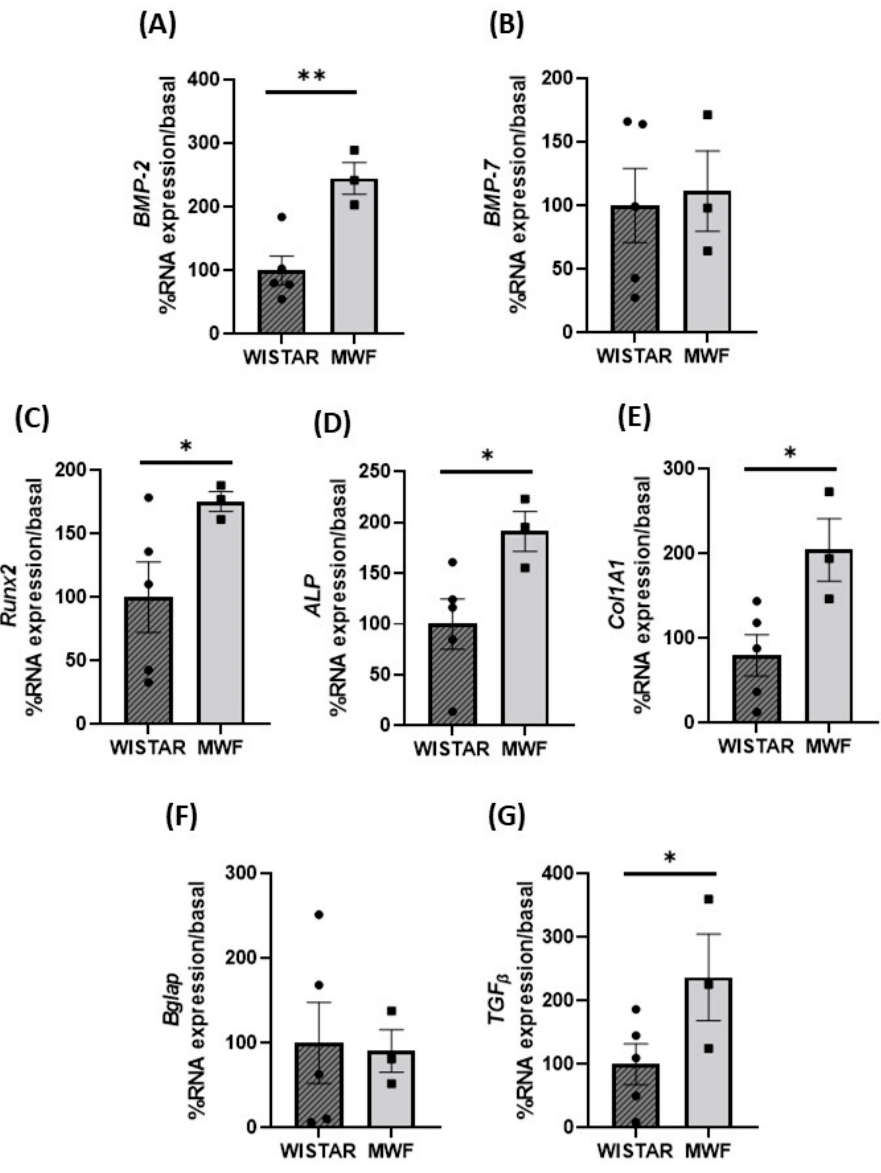
Figure 5. Expression of profibrotic and calcification makers in mesenteric perivascular adipose tissue (PVAT) of Wistar and MWF. mRNA expression level ( A ) BMP-2 , ( B ) BMP-7 , ( C ) Runx2 , ( D ) Bglap , ( E ) alkaline phosphatase ( ALP ), ( F ) collagen 1A1 ( Col1A1 ), and ( G ) TFG β mRNA expression level. Data are expressed as the mean ± SEM of n = 3–5 animals per group). * p < 0.05, and ** p < 0.01 compared to Wistar.